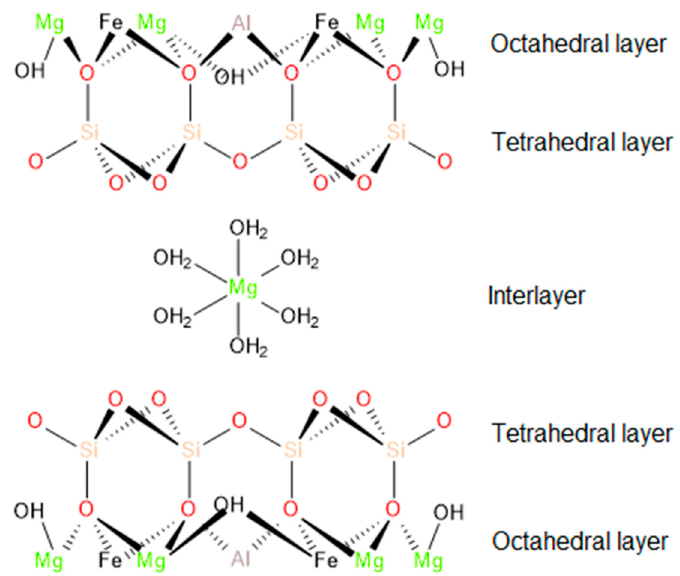
Figure 1. Structure of vermiculite.